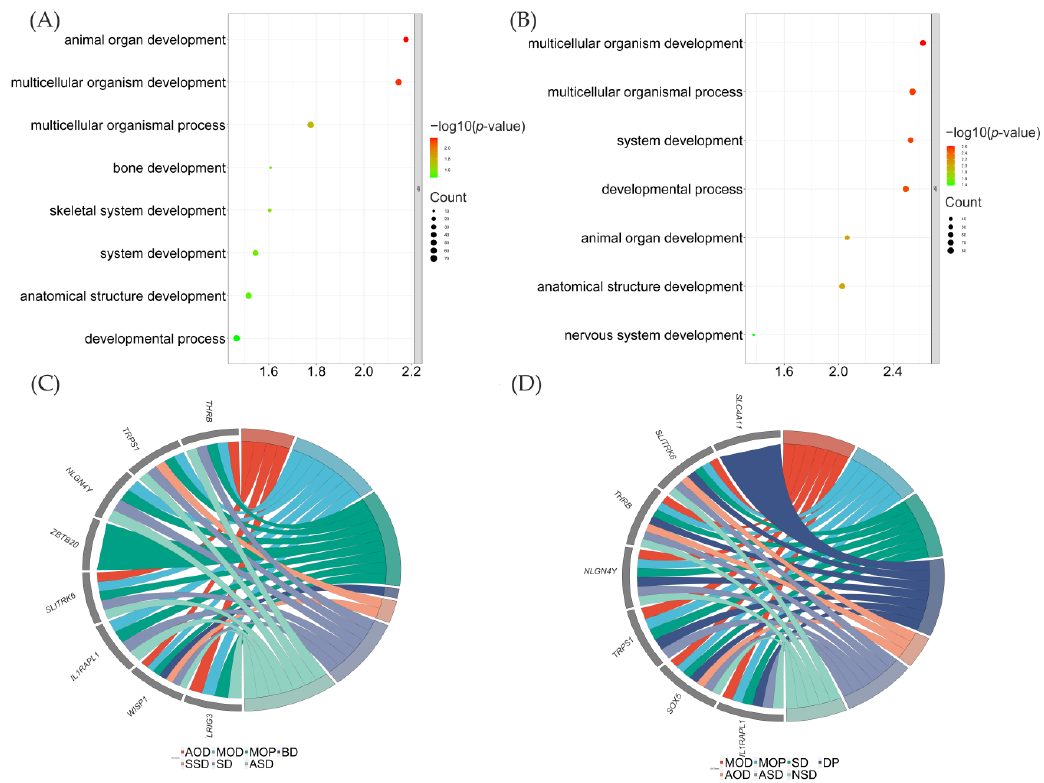
Figure 6. GO enrichment of genes shared between selective sweeps and DEGs in the midbrain. (A) LXFC-TC chickens. (B) LXFC-WL chickens. (C) Chord diagram of overlapping genes between